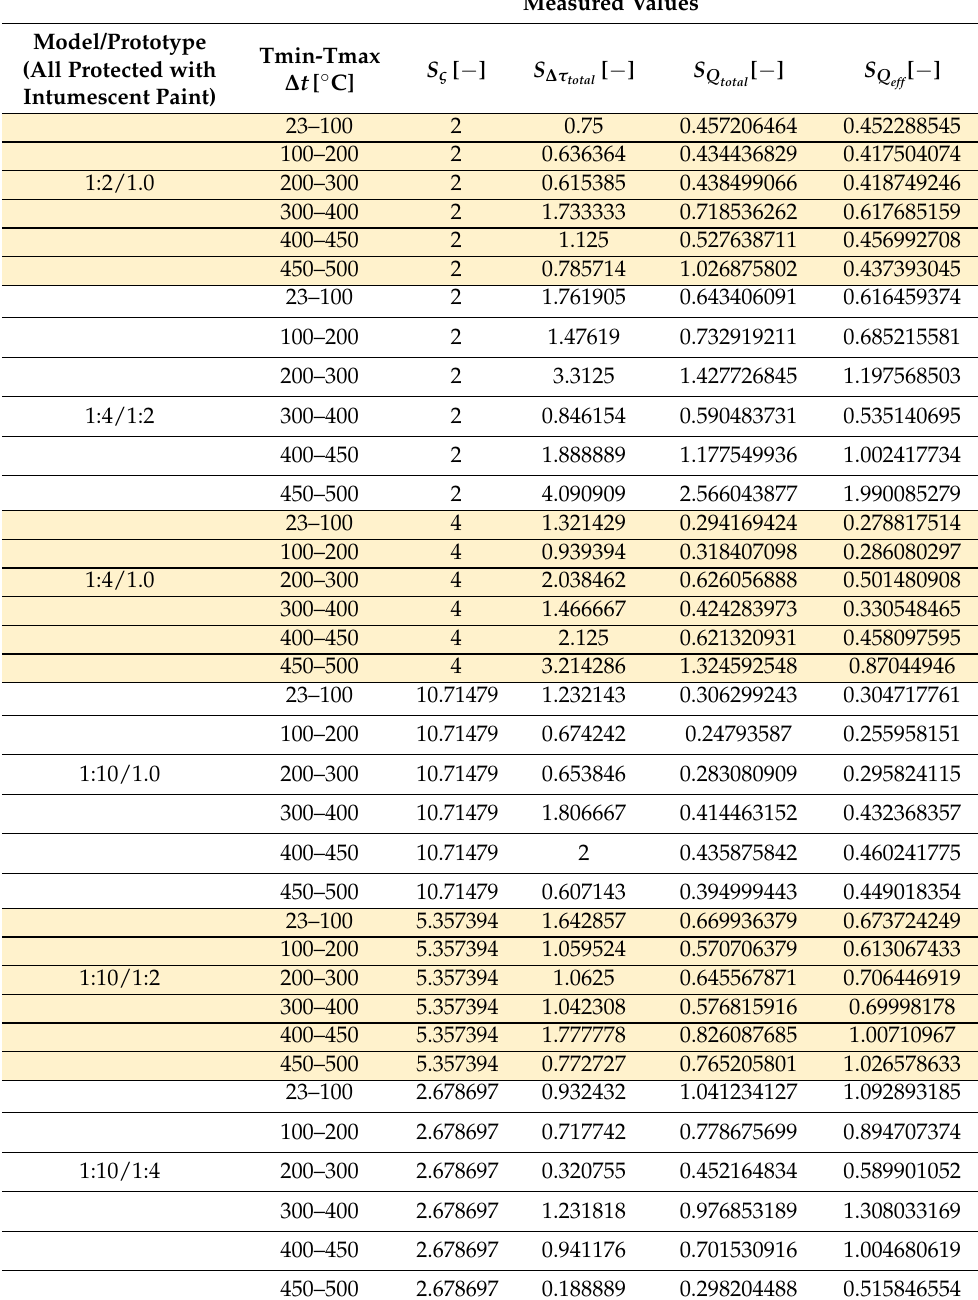
Table 4. Version I. Values obtained using direct